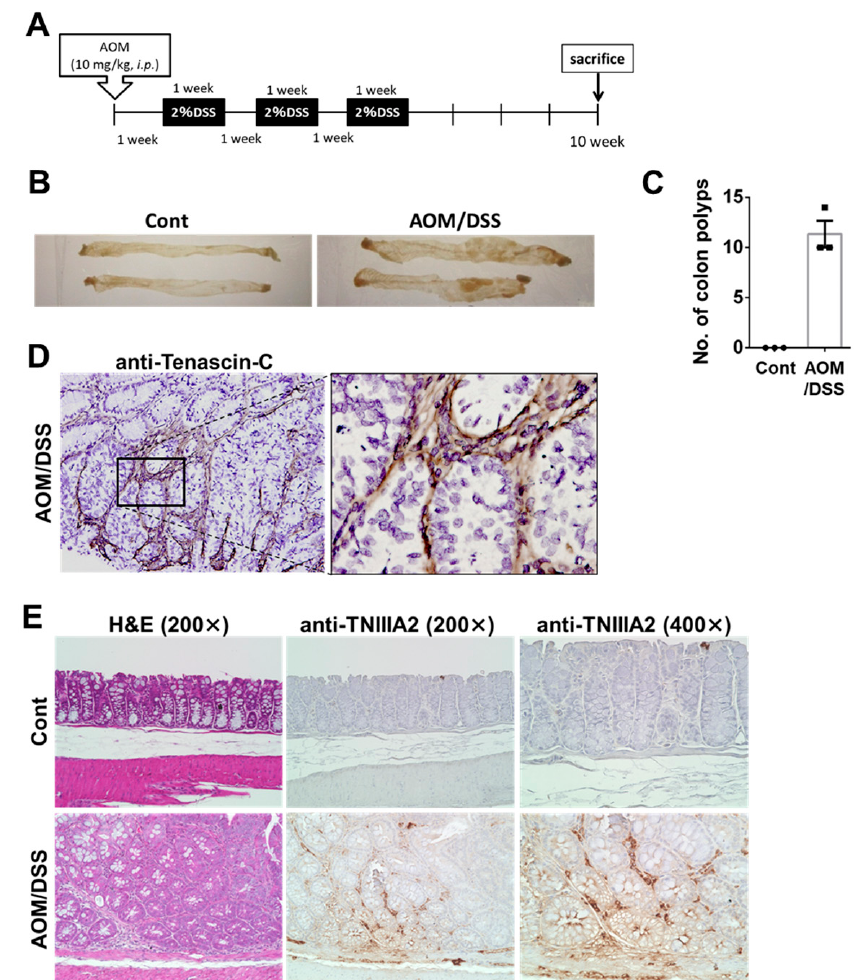
Figure 1. TNC / TNIIIA2 expressed in murine AOM / DSS colitis-associated carcinoma model. ( A ) Schematic of AOM and DSS administration to mice. ( B ) Macroscopic view of the resected colon in control and AOM / DSS-treated mice. ( C ) Tumor incidence in the AOM / DSS model. Dot plots show the number of colon polyps of individual mice in each group with bars representing means ± standard deviation. ( D , E ) Paraffin-embedded colon sections were stained with hematoxylin and eosin (H&E), TNC, and TNIIIA2 (original magnification 200× and 400×).